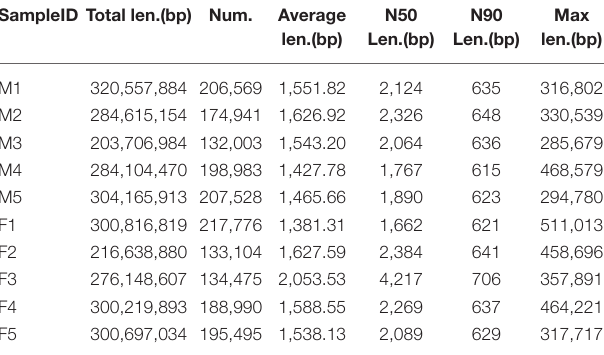
TABLE 2 | A summary of the assembly results. SampleID Total len.(bp)